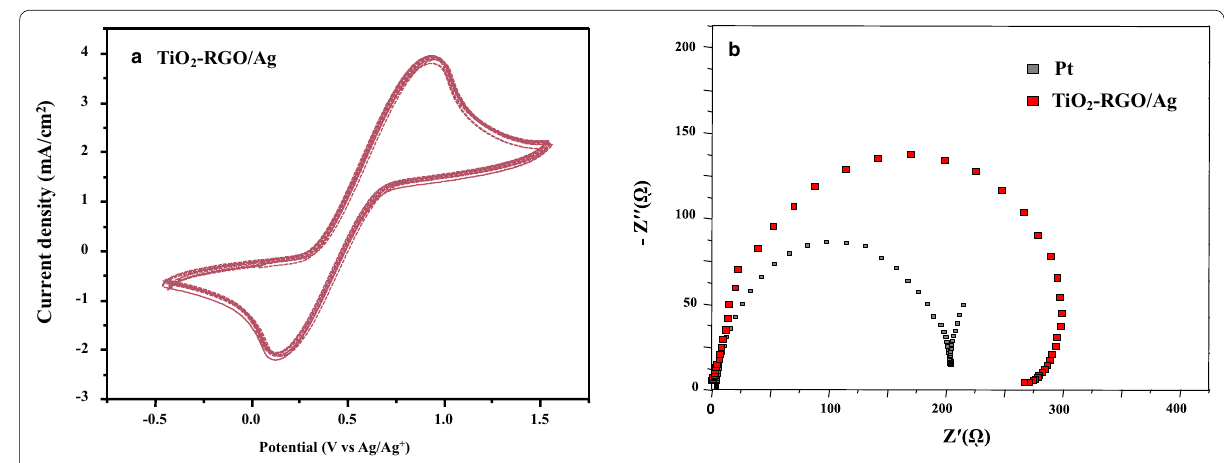
Fig. 8 Cyclic voltammetry and Nyquist plot of TiO 2